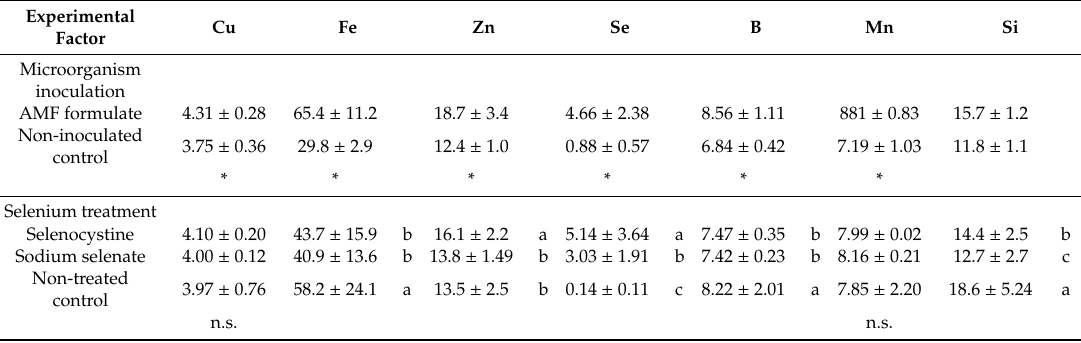
Plants 2019 , 8 , 102 Table 5. Shallot bulb micro-elemental composition as a ff ected by microorganism inoculation and Table 5. Shallot bulb micro-elemental composition as affected by microorganism inoculation and selenium treatment. selenium treatment.